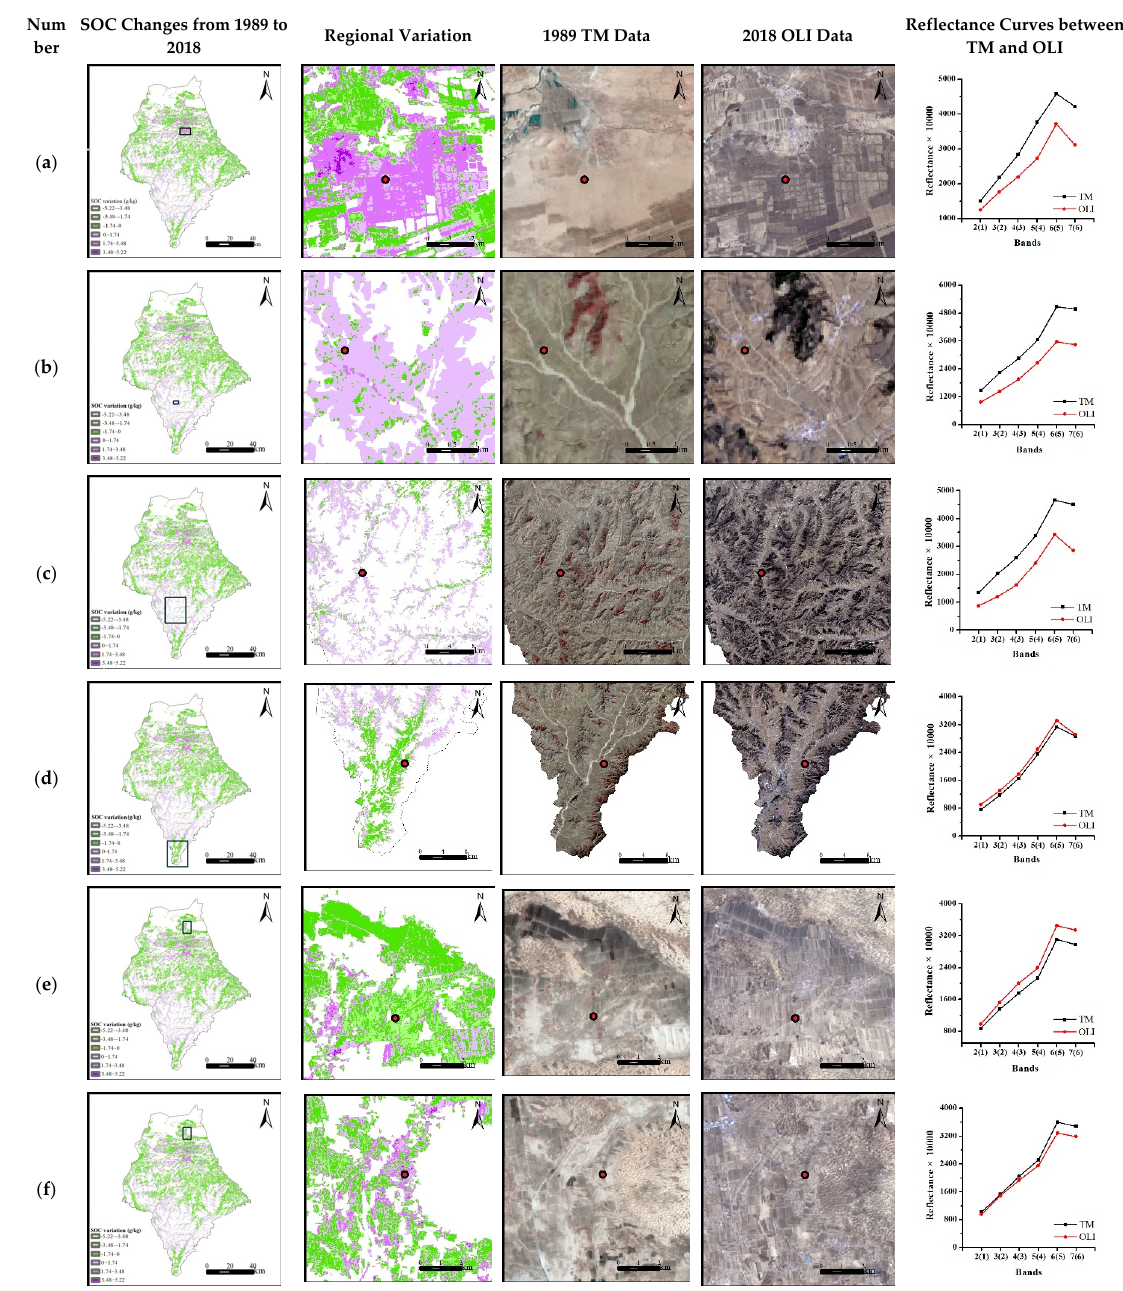
Figure 8. A comparison of the remote sensing data between 1989 and 2018 in typical areas ( a – f ) (From left to right are Scheme 1989. to 2018, regional variation, 1989 TM data, 2018 OLI data and reflectance curves between TM and OLI in the places of the dots, respectively.).